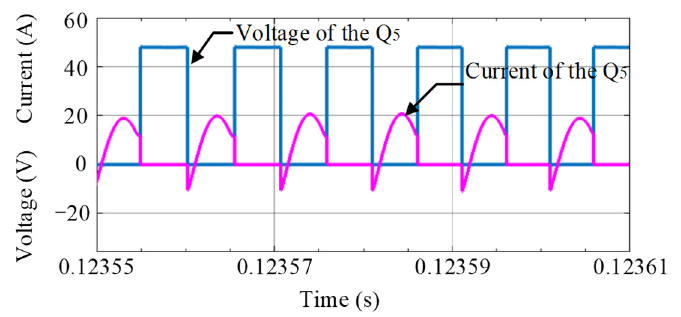
Figure 23. Voltage and current of Q 5 .